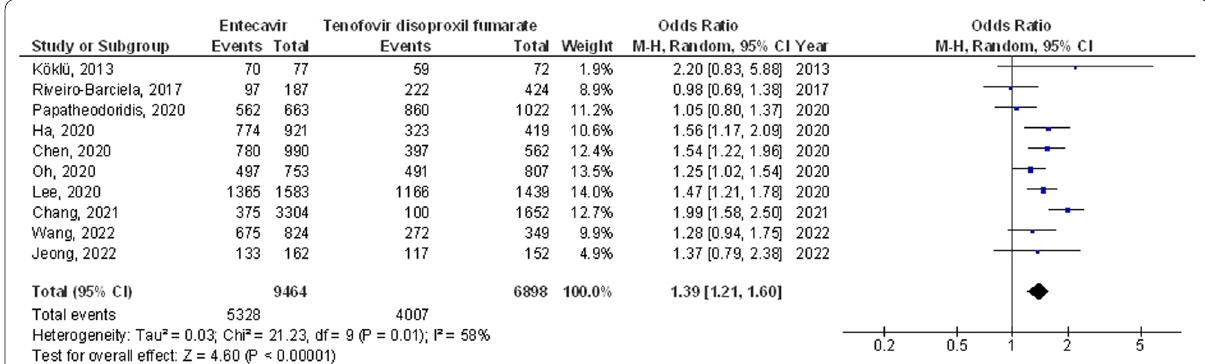
Fig. 2 Difference between the impact of entecavir and tenofovir disoproxil concerning results of biochemical response in chronic HBV